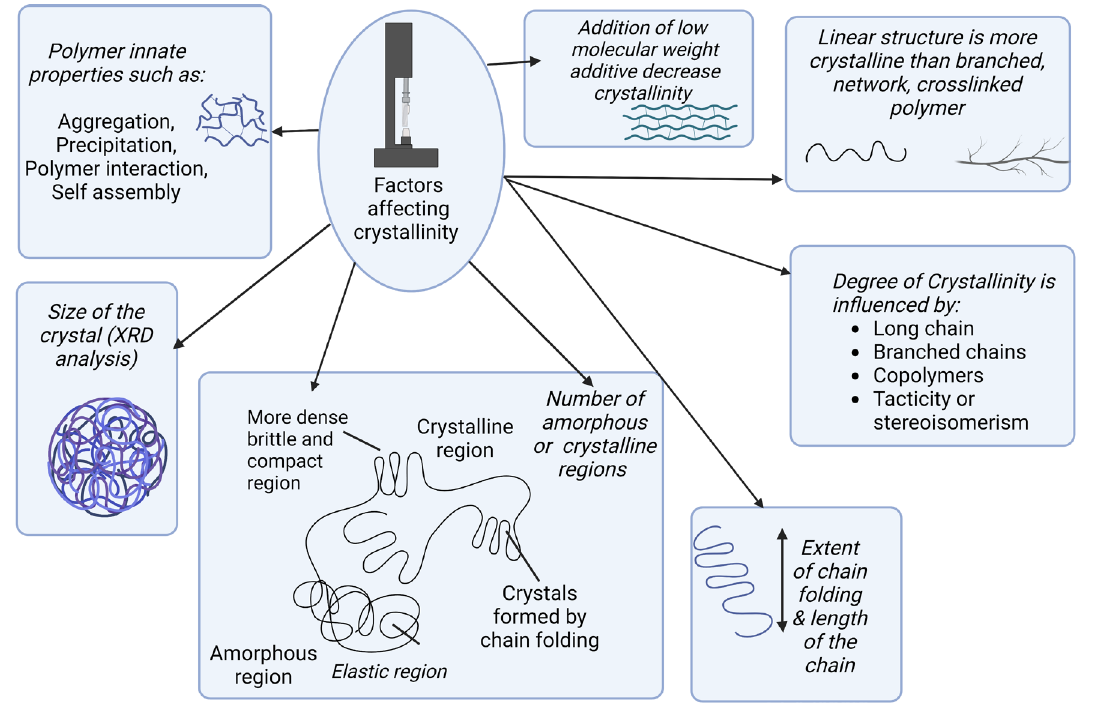
Figure 2. The effect of crystallinity on the mechanical attributes of edible films.